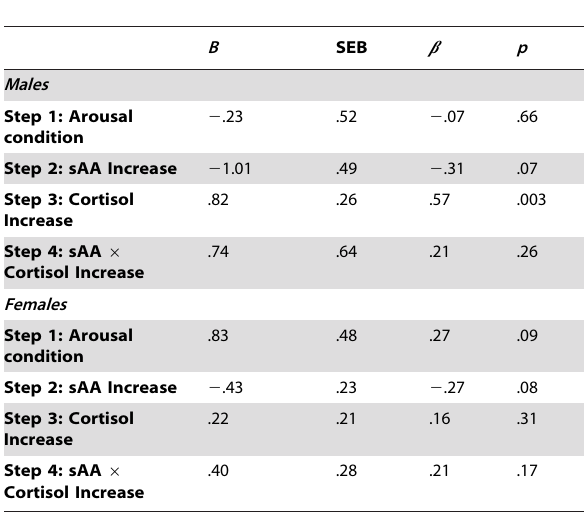
Table 4. Summary of Hierarchical Regression Models for Recall of Neutral